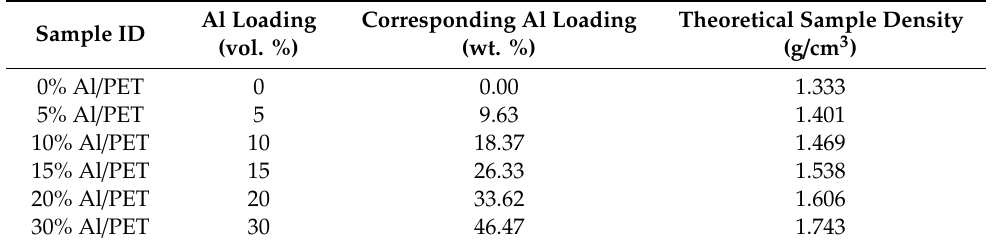
Table 2. Aluminum loading percentages and theoretical densities of Micro-Al 1 / amorphous PET composites. Note that for 20% and 30% Al 1, tensile bars could not be moulded without defects. However, Izod bars could be moulded for all compositions.